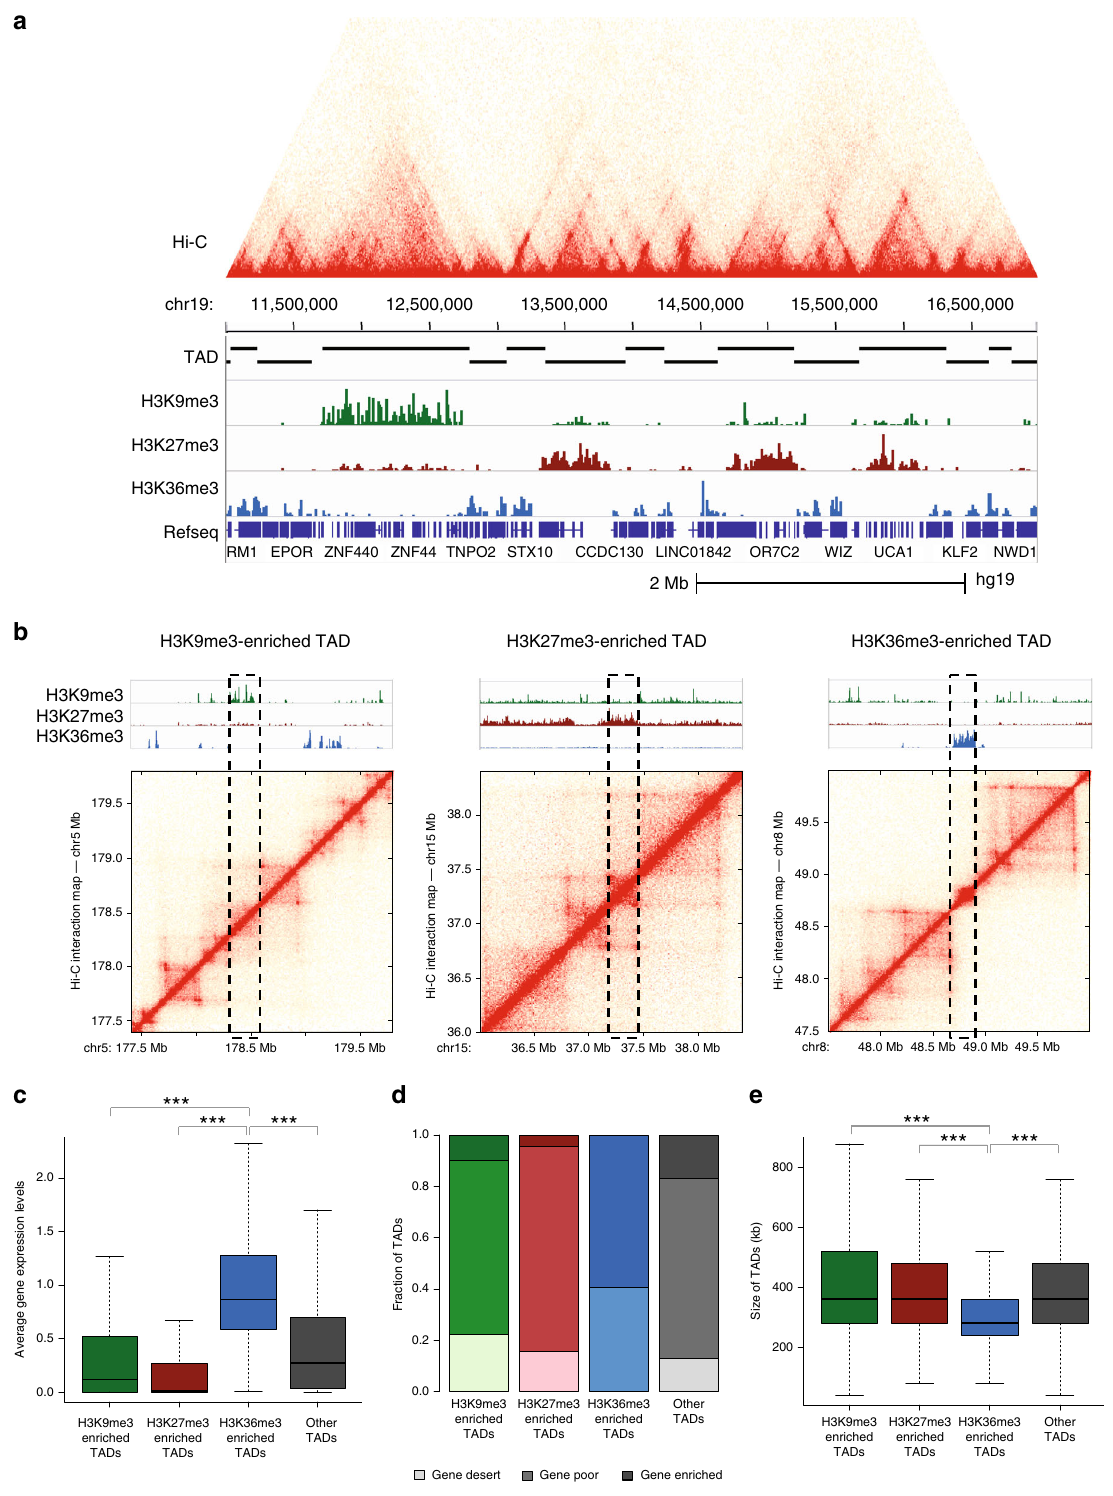
Fig. 2 Identi fi cation of histone mark-enriched TAD subgroups. a An example of an in situ Hi-C chromatin interaction map with histone-mark ChIP-seq tracks of a region of chromosome 19p13 in C42B prostate cancer cells. b Shown are in situ Hi-C chromatin interaction maps for a H3K9me3-, H3K27me- and H3K36me3-enriched TAD in C42B prostate cancer cells. Histone-mark ChIP-seq tracks from C42B prostate cancer cells are also shown. c Average expression levels of genes found in histone-mark-enriched TADs and TADs without those histone marks (other). d Fraction of gene desert (light), gene poor (mid), and gene enriched (dark) TADs for the histone mark-enriched TAD subgroups and other TADs. e Shown is the size of histone mark-enriched TADs and other TADs (Wilcoxon rank sum test, *adj. p value < 0.05, **adj. p value < 0.01, ***adj. p value <